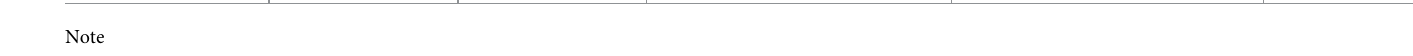
Note � AUC—area under the ROC.